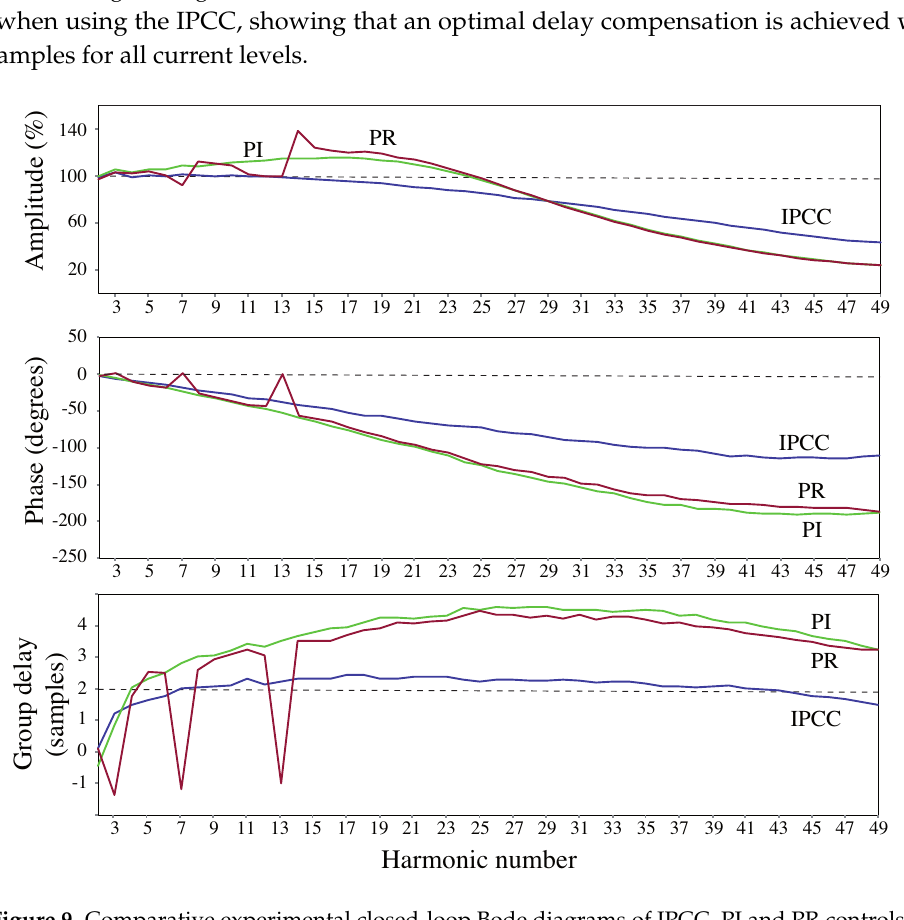
Figure 9. Comparative experimental closed-loop Bode diagrams of IPCC, PI and PR